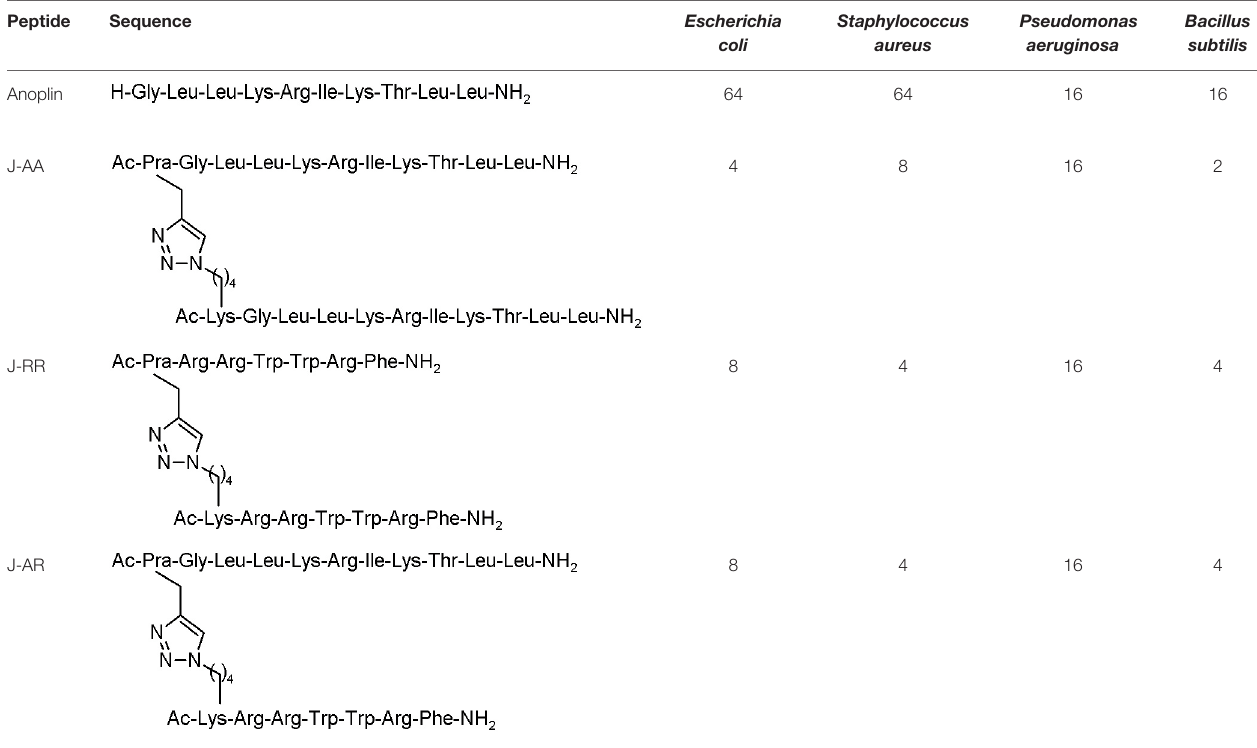
TABLE 4 | The structures of anoplin and its analogues with antibacterial activities with MIC values given in µ M (Liu et al., 2017a). Peptide